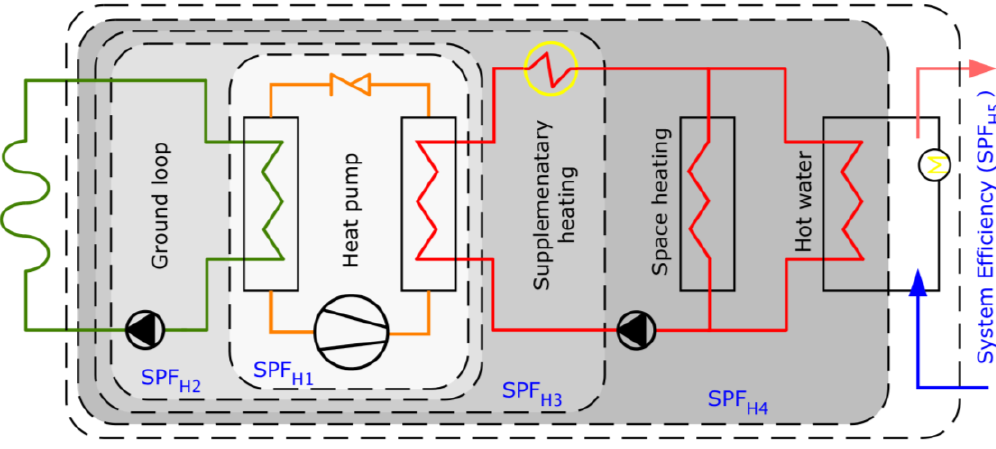
Figure 4. System boundaries and their relation to Seasonal Performance Factor (SPF) metrics 1–4. The system efficiency recorded in the first phase of the UK national field trials (SEFF) can be considered SPF and includes the output of the hot water H5